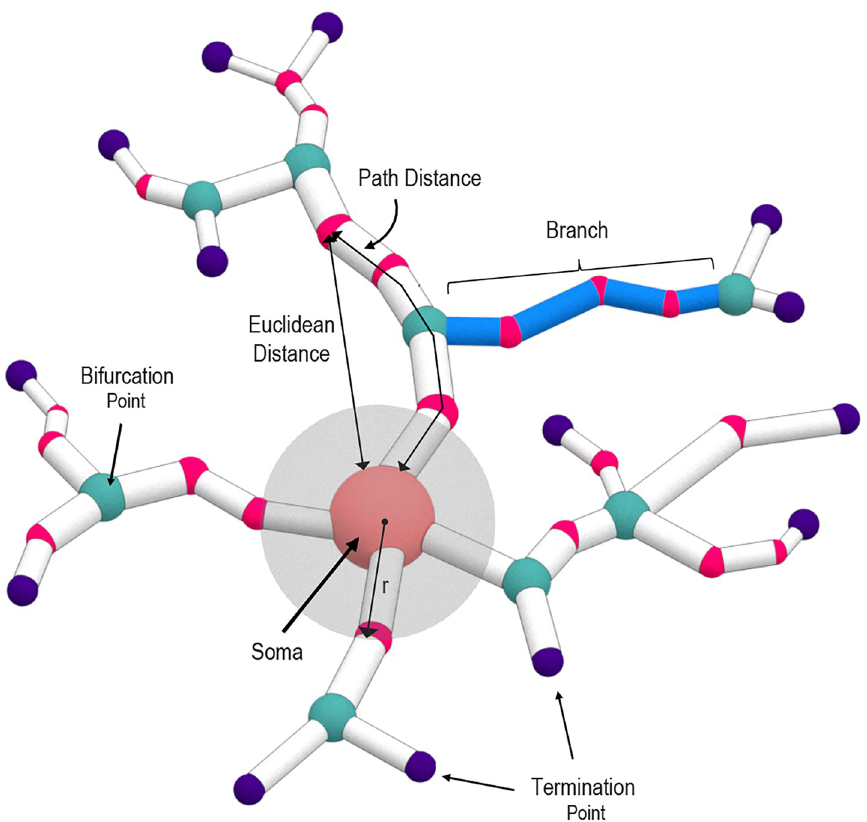
Fig 2. Representation of a neuronal tree structure. Schematic of a neuron illustrating key definitions used in the present work.